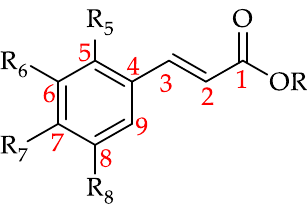
Figure 14. Basic structure of hydroxycinnamic acid and its derivatives (HCADs) (see 90 – 109 in Table 9). Table 9. Hydroxycinnamic acid and its derivatives reported in monofloral honeys (see Figure 14 for general structure).